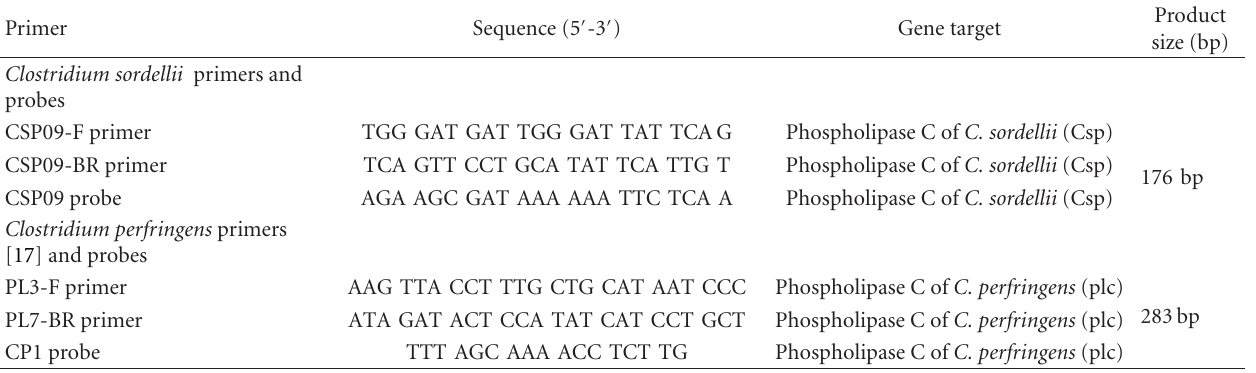
Table 1: Oligonucleotide primers and probes used in the duplex microsphere